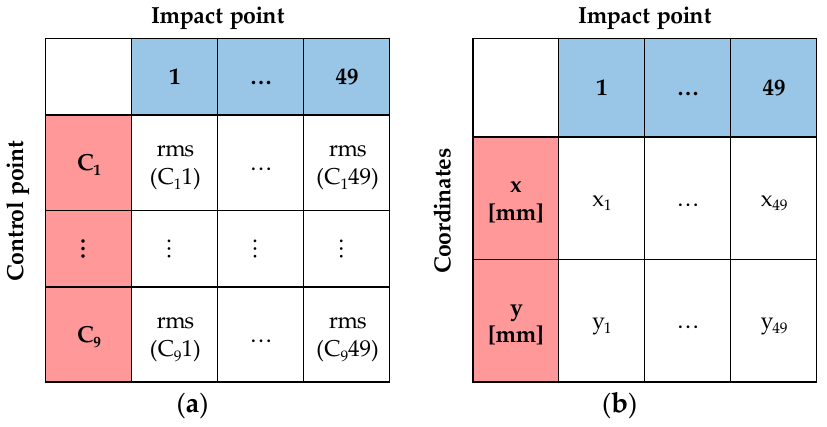
Figure 4. Architecture of training matrixes: ( a ) input matrix; ( b ) target matrix.